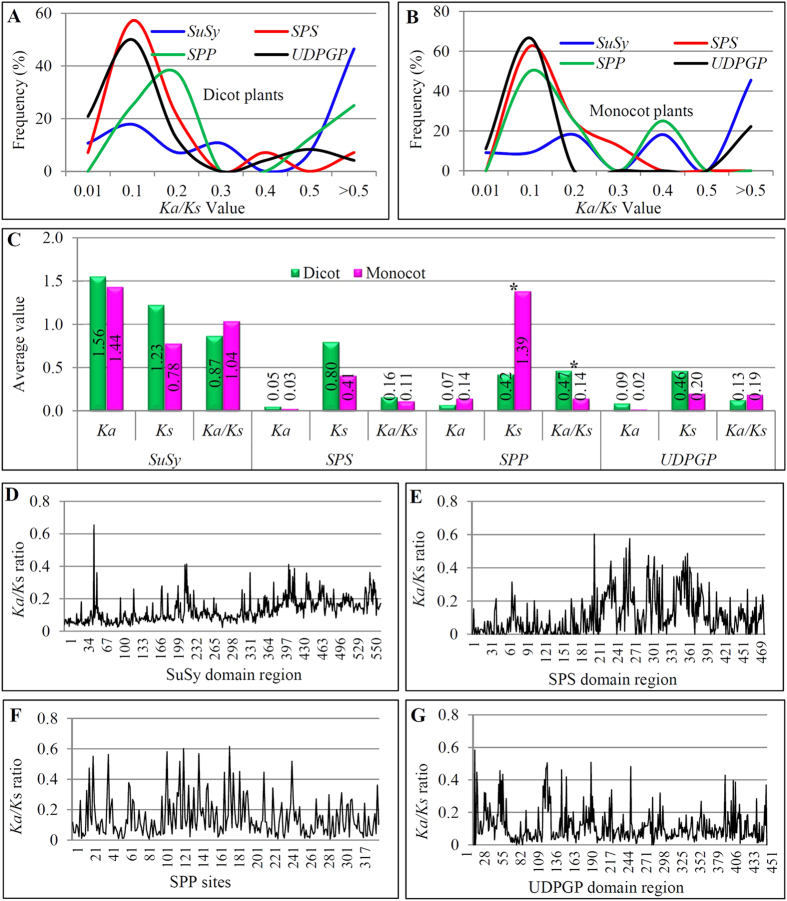
Frequency distributions of Ka/Ks ratios between expanded gene pairs and tests of sites with purifying/positive selection in the SuSy, SPS, SPP and UDPGP families.(A,B) Frequency distributions of Ka/Ks ratios were analyzed using expanded pairs from dicot and monocot plants, respectively. (C) The average Ka, Ks and their ratios in monocot and dicot pairs. Asterisks indicate significant differences between monocot and dicot plants at P, 0.05 (*) by t-test. (D–G) Screening for amino acid sites with purifying/positive selection in the four gene families by the SLR program as described in the Methods.